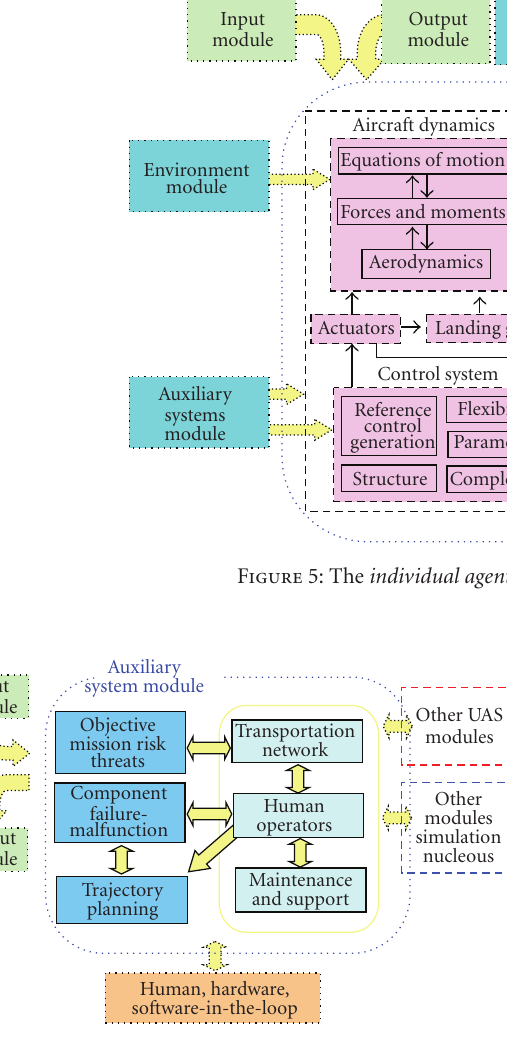
Figure 6: UAS-SE—auxiliary systems